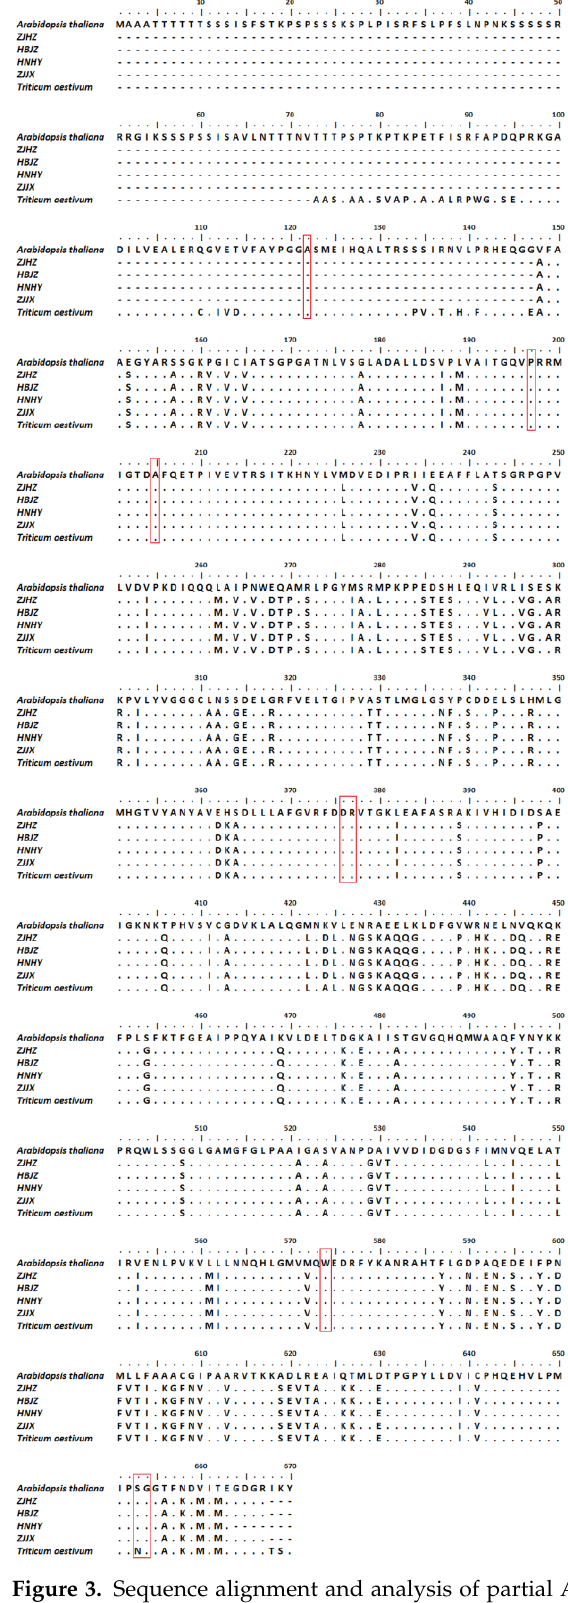
Figure 3. Sequence alignment and analysis of partial ALS gene from four R. kamoji populations, Arabidopsis thaliana and Triticum aestivum . Amino acid numbering refers to the A. thaliana ALS gene sequence. The boxed region indicates the eight reported mutations Ala122, Pro197, Ala205, Asp376, Arg377, Trp574, Ser653, and Gly654, which confer target-site resistance to ALS herbicides. 2.4. Enzyme-Linked Immunosorbent Assay (ELISA) of ALS, CytP450 and GST Activities The enzyme ELISA tests over a period of 14 d indicated that activities of ALS, CytP450, and GST in R. kamoji ZJHZ were close to that of T. aestivum , and showed similar responses after metsulfuron-methyl treatment. ALS activity decreased in both R. kamoji